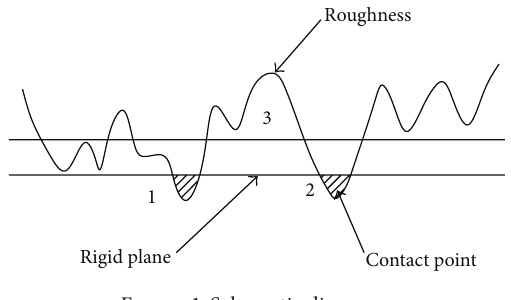
Figure 1: Schematic diagrams.